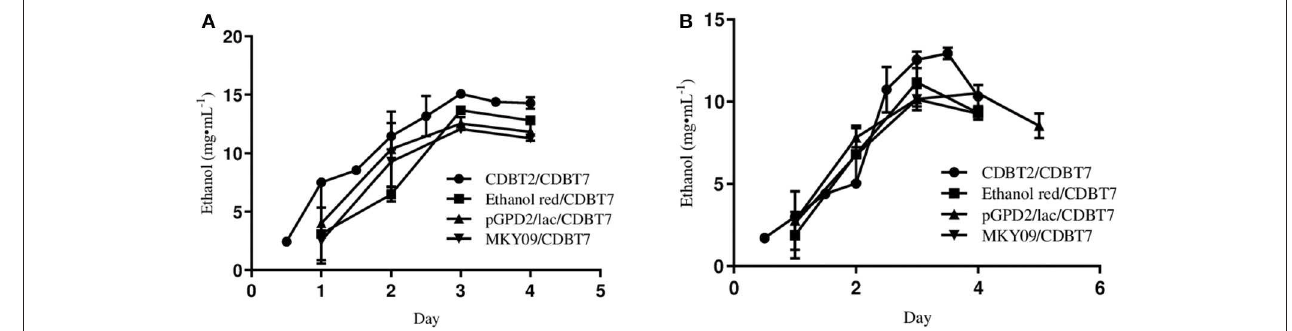
FIGURE 4 | Ethanol production by various S. cerevisiae strains cultured in anodic compartment of electrochemical cell with CDBT7 cultured in cathodic compartment: a comparative study. (A) Ethanol production in anodic compartment. (B) Ethanol production in cathodic compartment.